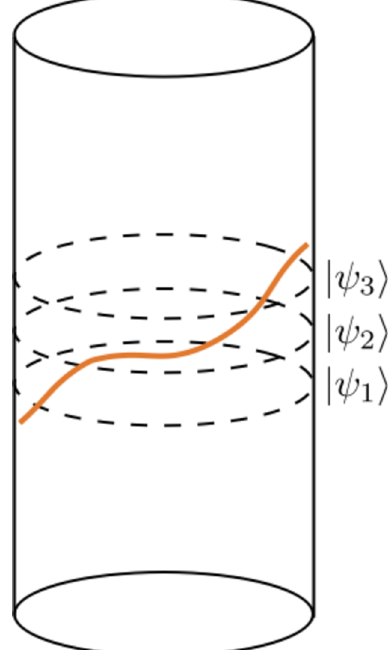
Figure 3 . An example of a time-dependent geometry limiting to different boundary states | ψ i i at each time. Could the Berry phase associated to state-dependent parallel transport compute the length of a curve (such as the thick orange curve) in such a